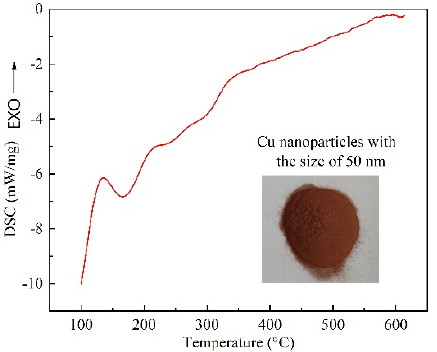
Figure 5. DSC curve of Cu nanoparticles.